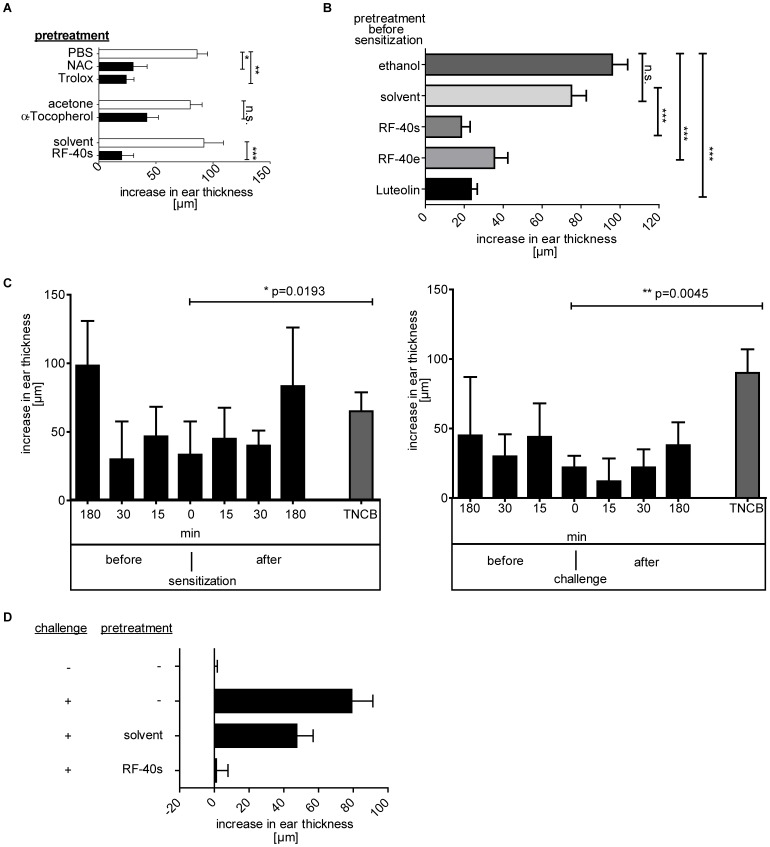
Effects of treatment with different antioxidants before and after sensitization or challenge on CHS responses.(A) Ears of mice were pre-treated by topical application of the antioxidants NAC, the hydrophilic Vitamin E analogon Trolox, the hydrophobic Vitamin Eα-Tocopherol or RF-40s or the respective solvent controls PBS, acetone or solvent before sensitization with TNCB (3%). 5 days later, increase in ear thickness was measured after challenge with TNCB (1%). Data represent the mean increase in ear thickness +/− SD of groups of five mice. One representative of two independent experiments is shown. (B) Mouse ear skin was treated 20 min before sensitization (TNCB 3%) with either RF-40s, ethanol dissolved RF-40 (RF-40e) or ethanol dissolved pure Luteolin (<98% HPLC) with the same molar concentrations of Luteolin. 24 h after challenge (TNCB 1%), increase in ear thickness was measured. The data represent the mean increase in ear thickness of groups of n = 5 mice +/− SD. One of two independent experiments is shown. (C) Ears of mice were treated with RF-40s at different times before or after sensitization (left) or challenge (right) with TNCB and increase in ear thickness was measured 24 h later. Data show mean increase in ear thickness +/− SD from one of two independent experiments with n = 5 mice/group. (D) Mice sensitized to oxazolone (3%) were either left untreated or were pre-treated with RF-40s or solvent 15 min before challenge with oxazolone (1%). Data represent mean increase in ear thickness of groups of n = 5 mice +/− SD. One representative of three independent experiments is shown.